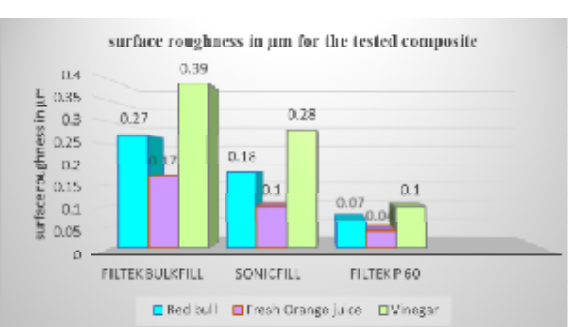
Figure 2: surface roughness of the three tested